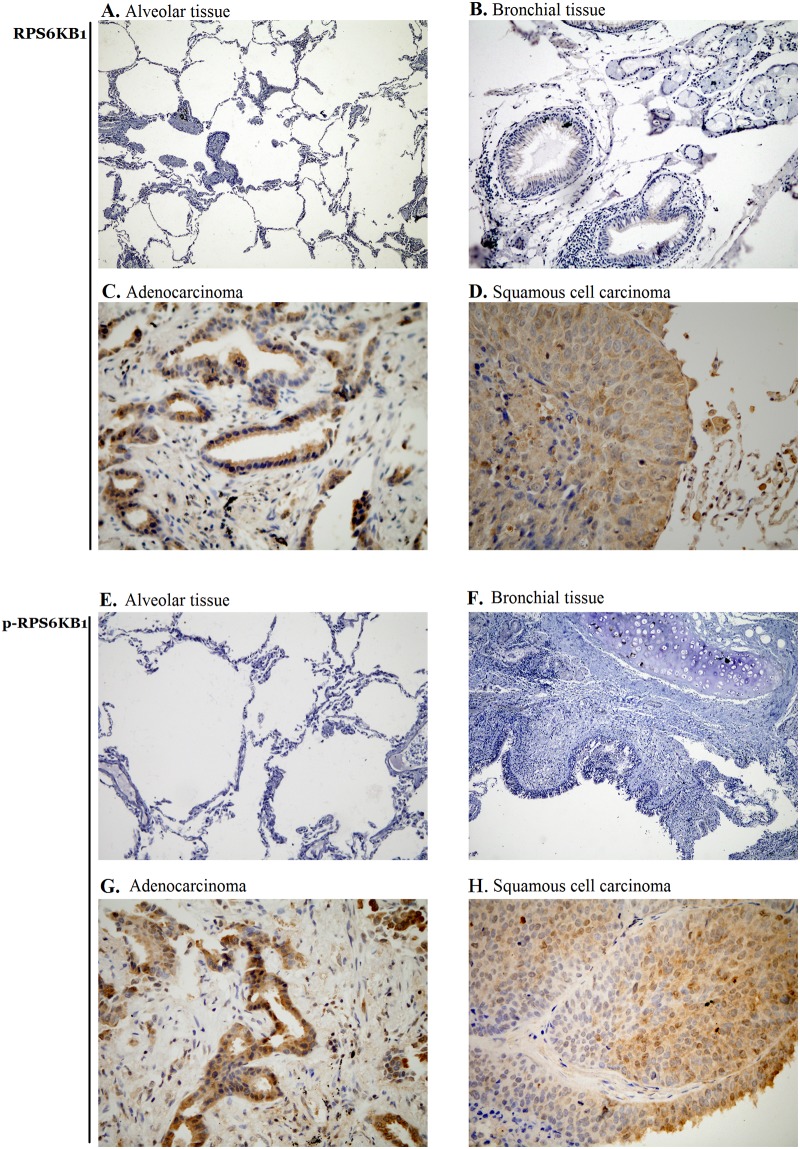
Expression of RPS6KB1 and p-RPS6KB1 NSCLC samples and controls.(A, B) Representative images of negative expression of total RPS6KB1 in normal alveolar tissue and bronchial tissue (× 100). (C, D) Representative images of strong expression of total RPS6KB1 in lung adenocarcinoma and squamous cell carcinoma (× 200). (E, F) Representative images of negative expression of p-RPS6KB1 in normal alveolar tissue and bronchial tissue (× 100). (G, F) Representative images of strong expression of p-RPS6KB1 in lung adenocarcinoma and squamous cell carcinoma (× 200).